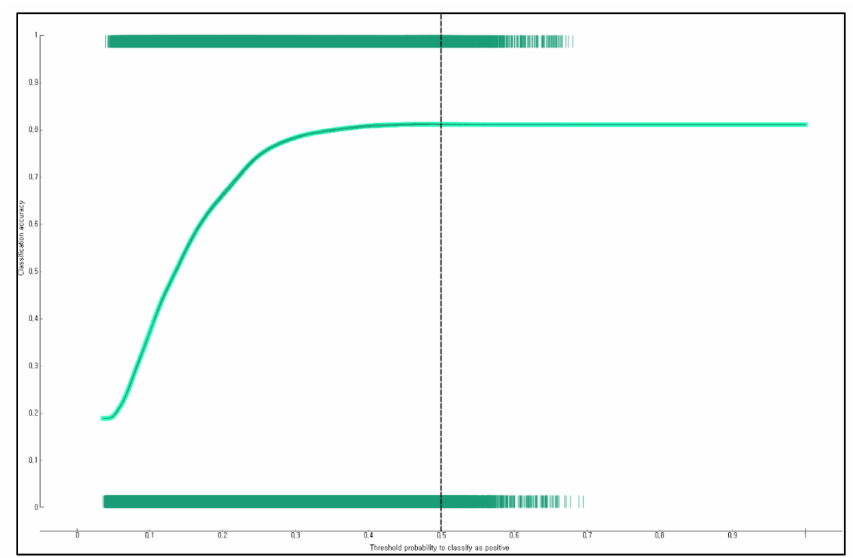
Figure 6. Classification accuracy of the nomogram for predicting anxiety due to COVID-19 for adults living in South Korean communities.